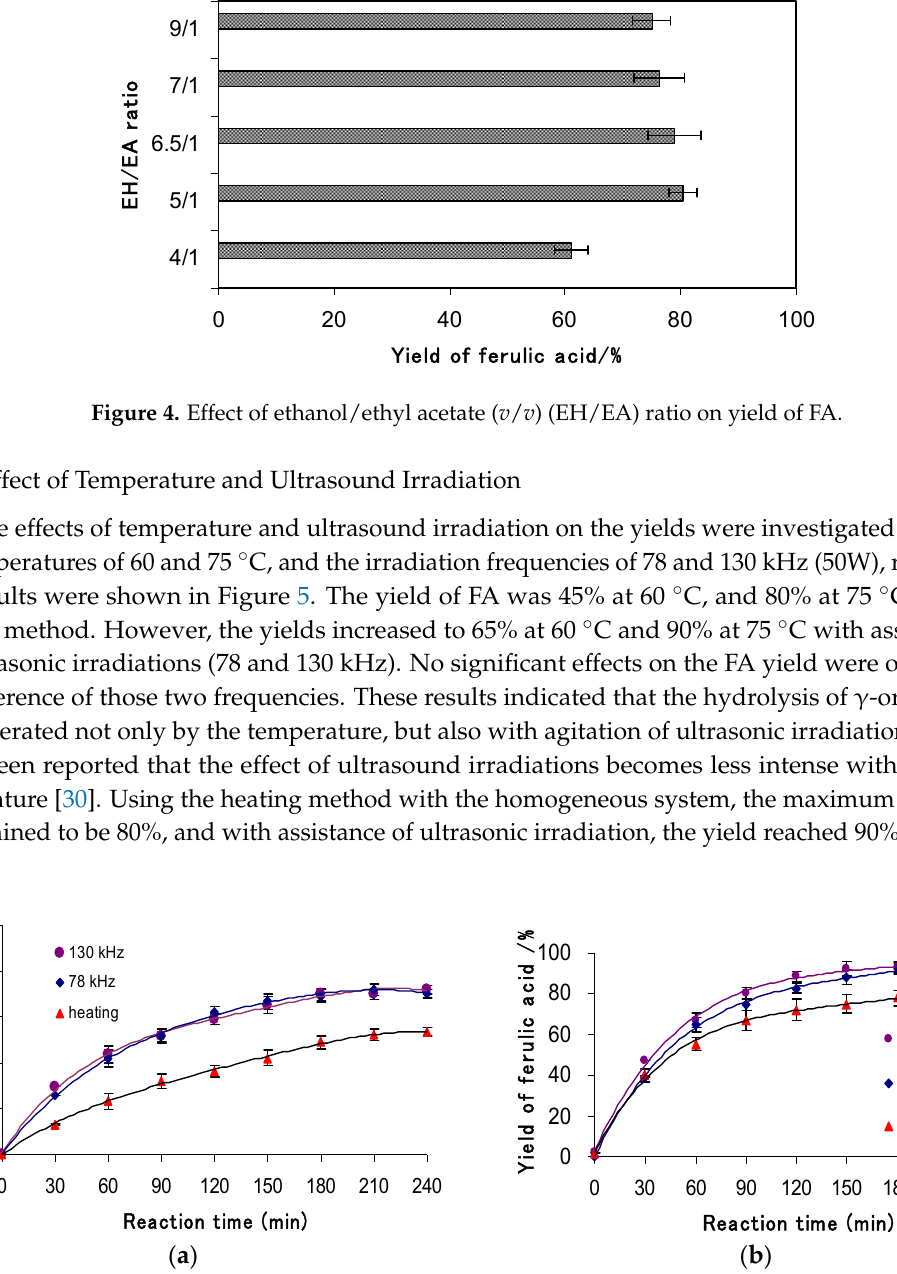
( b ) Figure 3. Effect of initial concentration of γ‐ oryzanol ( a ) and KOH/ γ‐ oryzanol ( wt / wt ) ratio on yield of ferulic acid (FA) ( b ) 3.2.2. Effect of the Cosolvent Ratio The effect of cosolvent ratios (EH/EA) on yields of FA were examined with the following conditions: the initial concentration of γ‐ oryzanol 12 mg/mL, KO ratio 10/1, reaction temperature 75 °C, and 4 h. The EH/EA ratio was varied from 2/1 to 9/1, however the precipitate appeared with